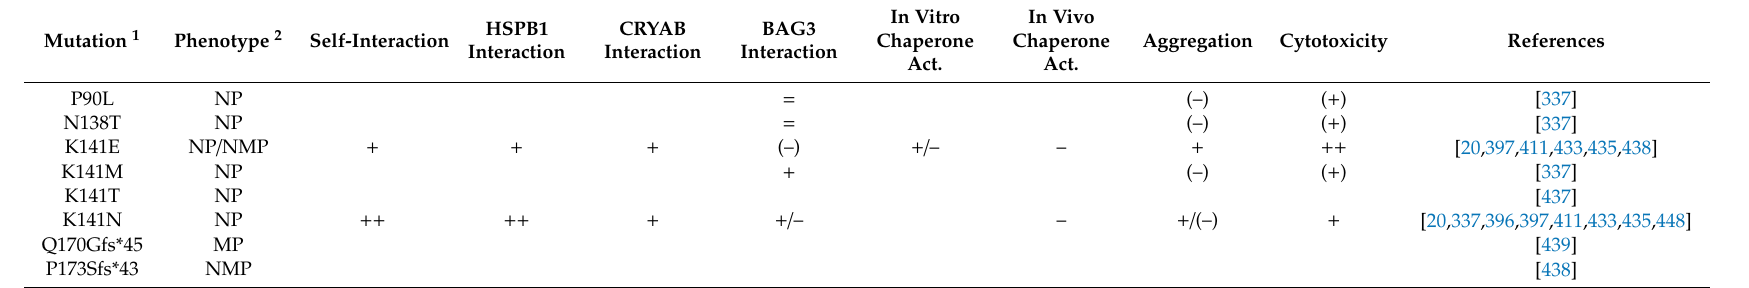
Table 8. HSPB8 mutations causing neuromuscular